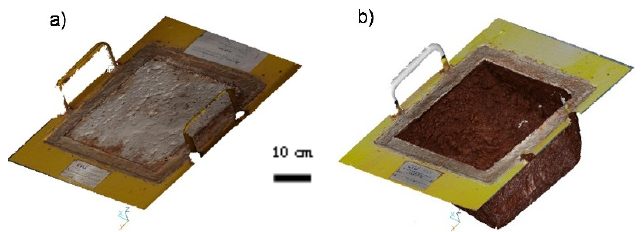
Figure 2. Scan images showing 3D model data combined with photographs of soil sample treated with lime: ( a ) before the test and ( b ) after the test.